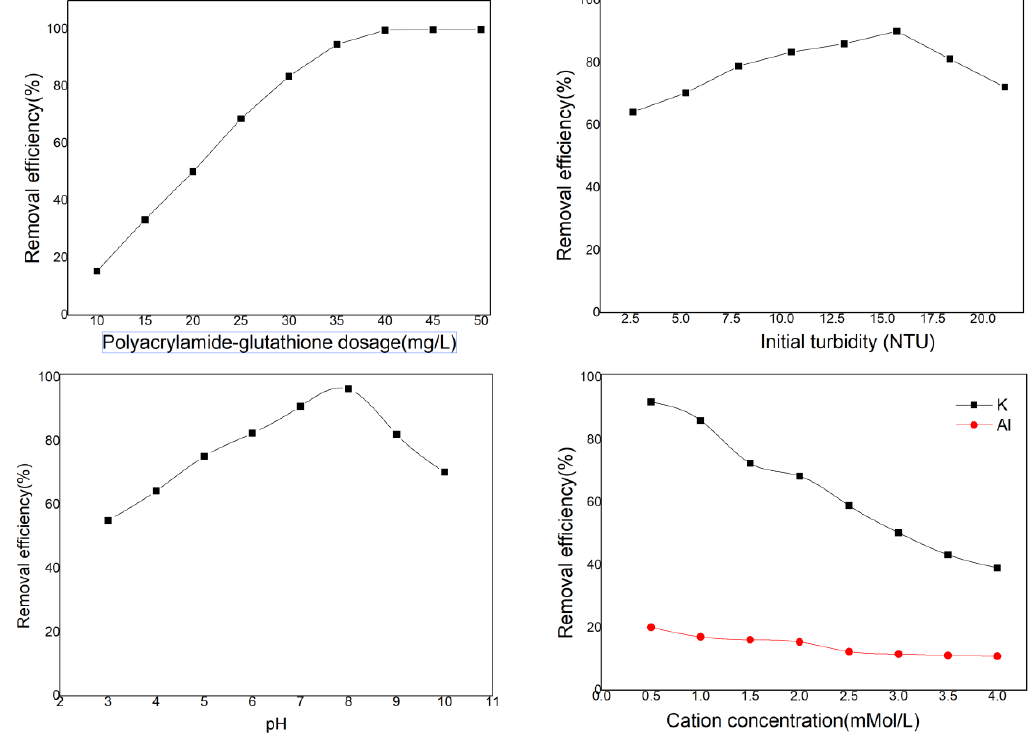
Figure 7. Cadmium removal performance tests.